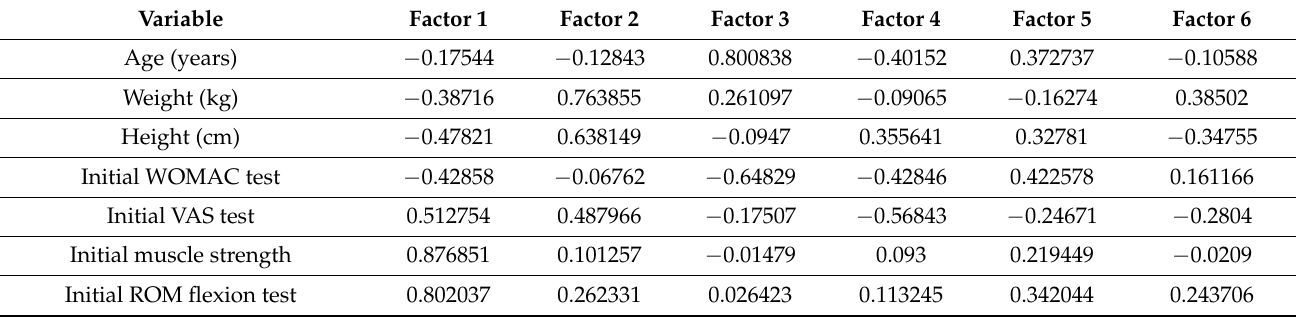
Table 8. Factor coordinates of the variables based on correlations for the pilot group (PG) at the initial